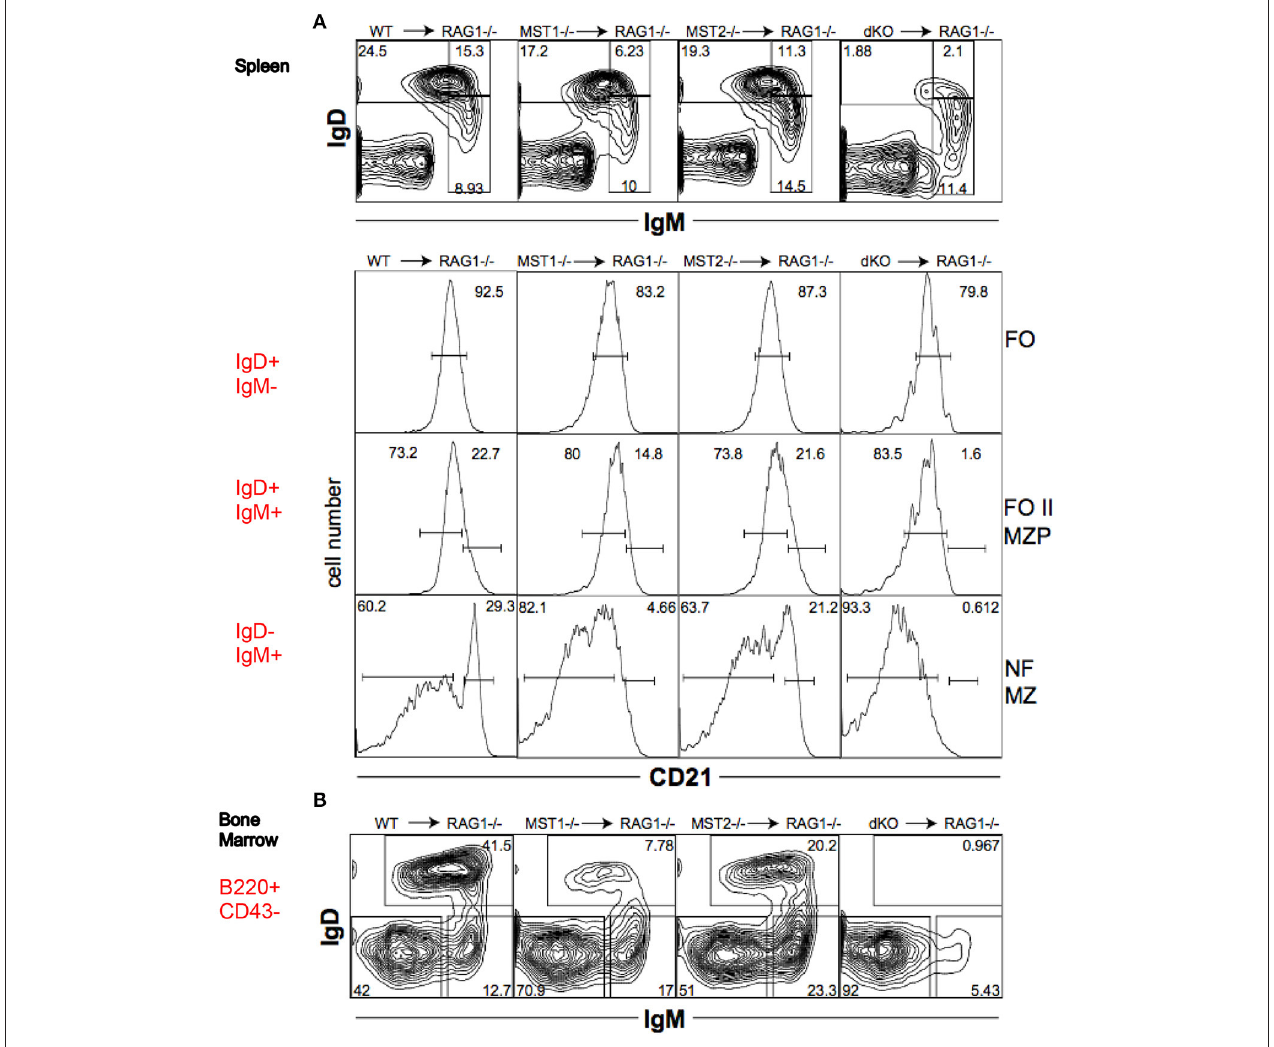
FIGURE 5 | Mst1 and Mst2 are important for normal B cell development in a cell intrinsic manner. Rag-1 − / − mice were reconstituted with WT or mutant BM. Spleen and BM cells were analyzed 7 weeks later in the reconstituted mice. (Data are representative of 3 reconstituted mice for each group). (A) Reconstitution of different B cell sub-fractions in the reconstitute Rag1 − / − mice. Both IgD + IgM + CD21 + MZP and IgD − IgM + CD21 + MZ fractions are impacted. (B) Reconstitution of the different B cell fractions in the bone marrow of recipient Rag1 − / − mice. B220 + CD43 − IgD + IgM + fraction F is depleted in Mst1 − / − and Mst1/Mst2-dKO